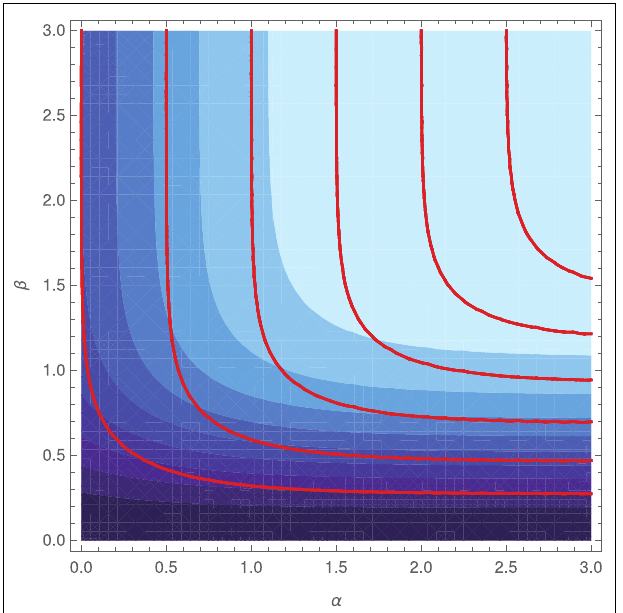
FIGURE 11 | Mutual information and fixed marginals . The shades of blue represent the amount of I p ( Y : X 1 , X 2 ) as a function of (cid:11) , (cid:12) (brighter is higher). Each red line represents a family ∧ of fixed marginals. While the lines of fixed mutual information and the families of fixed marginals look qualitatively similar, they do not coincide exactly, which means that I p varies within the ∧ .